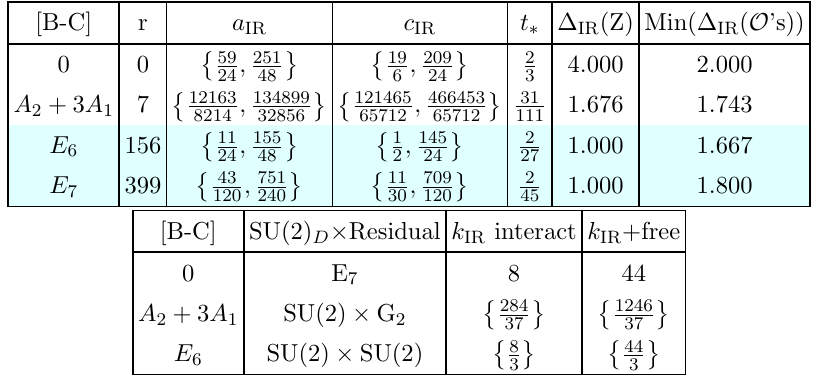
Table 15. Flipper (cid:12)eld deformations of the Minahan-Nemeschansky theory with E 7 (cid:13)avor, only rational values. The top table has the central charges a IR and c IR as well as scaling dimensions while the table below contains the information about the (cid:13)avor central charges. The cyan highlighted entries align with the H 0 and H 1 Argyres-Douglas theories, as (cid:12)rst noted in [17]. Compared with reference [17], we also (cid:12)nd an additional (cid:13)ipper (cid:12)eld deformation which yields the H 1 theory for the E 6 Bala-Carter label, with embedding index r = 156. The other rational central charges are also in agreement with [87].